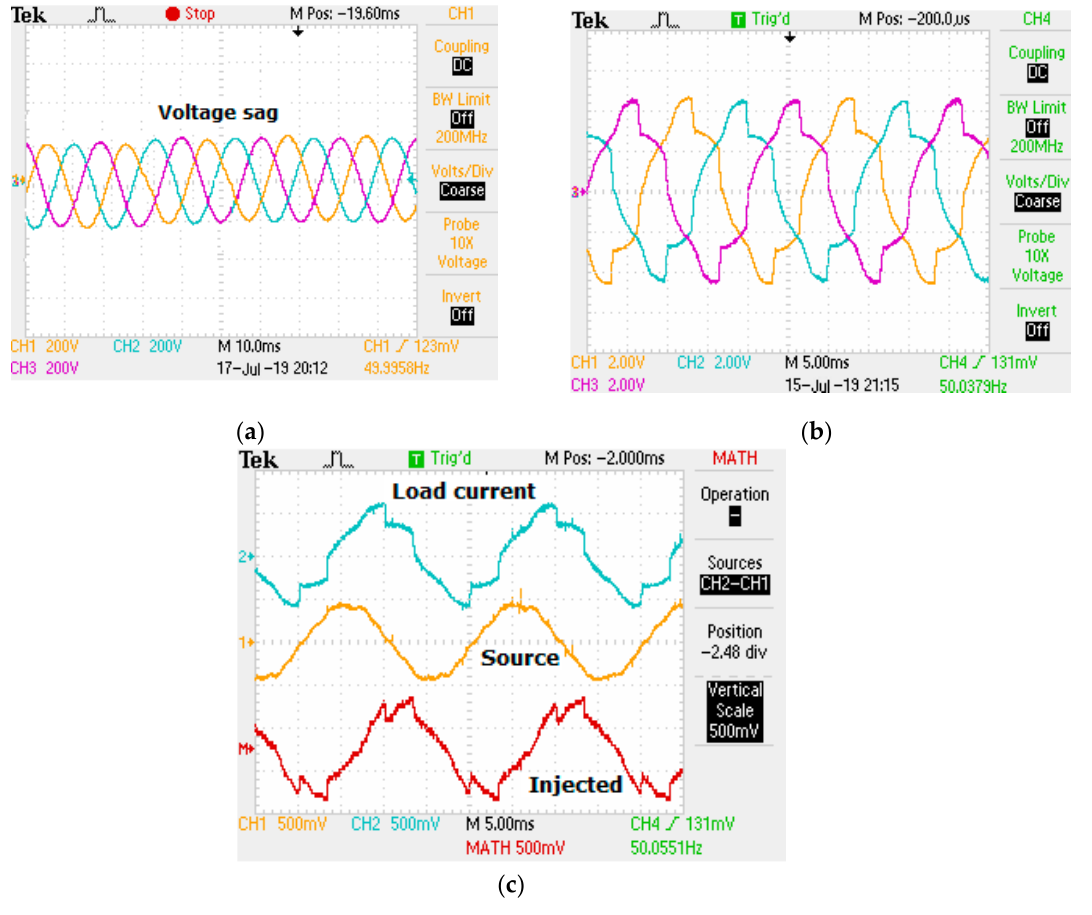
Figure 12. Experimental results under steady state voltage and current: (a) supply voltage; (b) load current; (c) load current, source current, and injected current.